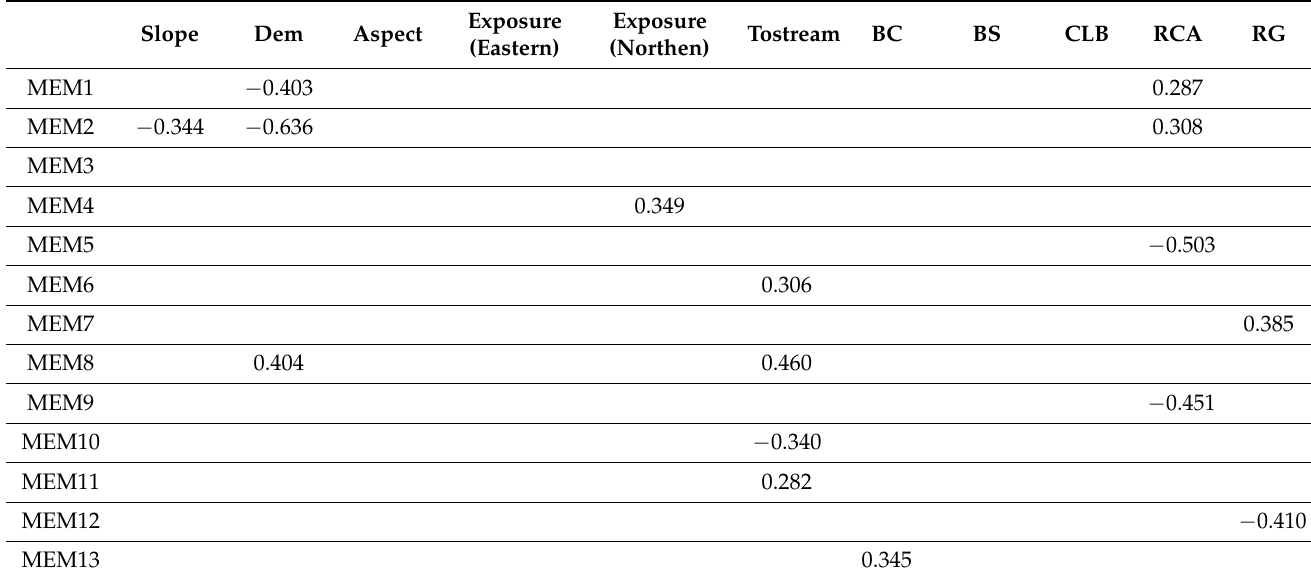
Table 5. Moran’s eigenvector maps and their statistically significant environmental